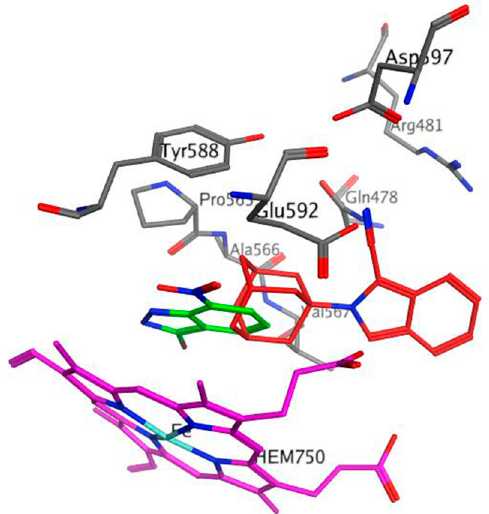
Figure 6. The putative binding modes and orientation of 3-bromo-7-nitroindazole (3B7NI) ( green ) and compound 1 ( red ) within the rat neuronal nitric oxide synthase (nNOS) heme domain active site. The heme cofactor (HEM750) is shown in magenta, and the surrounding amino acids are shown in grey.